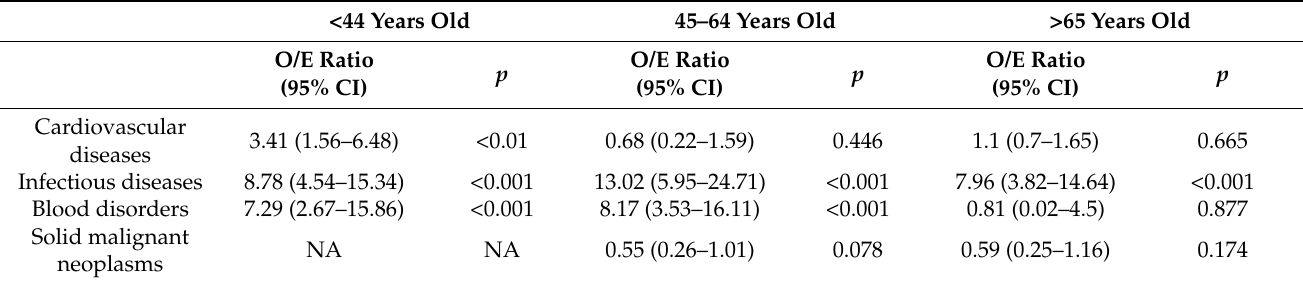
* For each death certificate that listed Still’s disease as a non-underlying cause of death (NUCD), the underlying causes of death (UCDs) were investigated and the observed number of deaths in relation to the expected number of deaths (O/E ratio) was calculated. 95%CI = 95% confidence